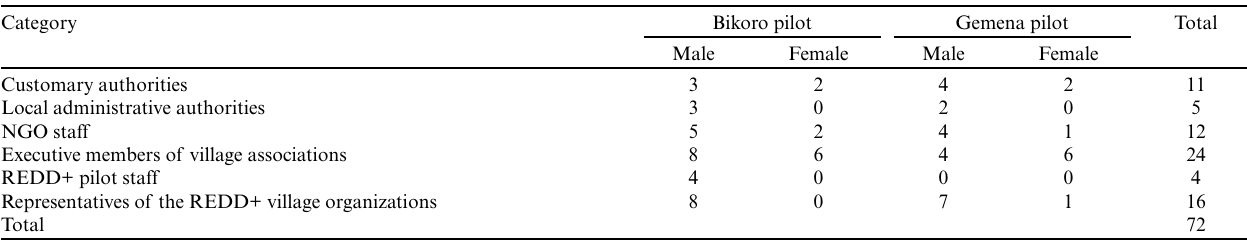
Table 2 . Category of actors interviewed in both